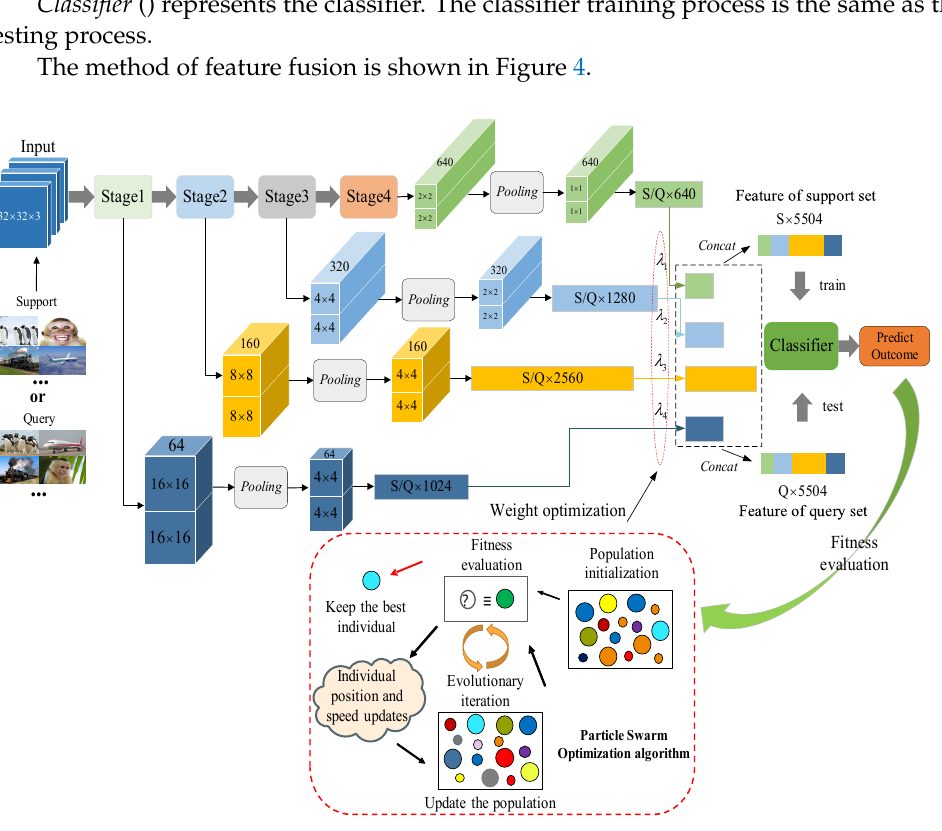
Figure 4. Feature fusion of different stages of the network. In the figure, a × a × b represents the dimension of the input feature; c × c denotes the feature dimension of each stage; S/Q denotes the size of support sets or query sets in a run; Pooling represents pooling operation; Concat indicates feature splicing.